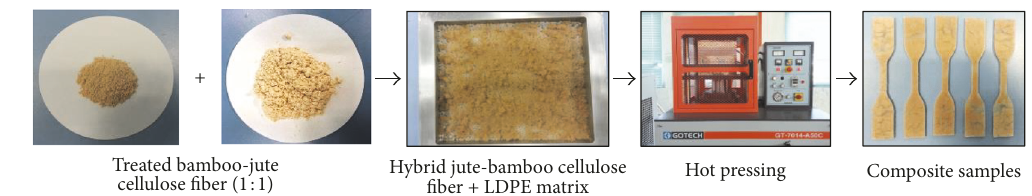
Figure 4: Flow of hybrid composite